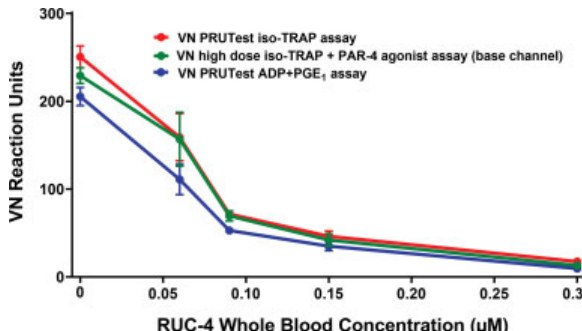
Fig. 6 In vitro RUC-4 concentration-response in inhibiting the VN iso- TRAP and base channel assays with blood from healthy volunteers not taking aspirin and anticoagulated with sodium citrate, n ¼ 3, 15 measurements, data are mean (cid:4) SD. VN ¼